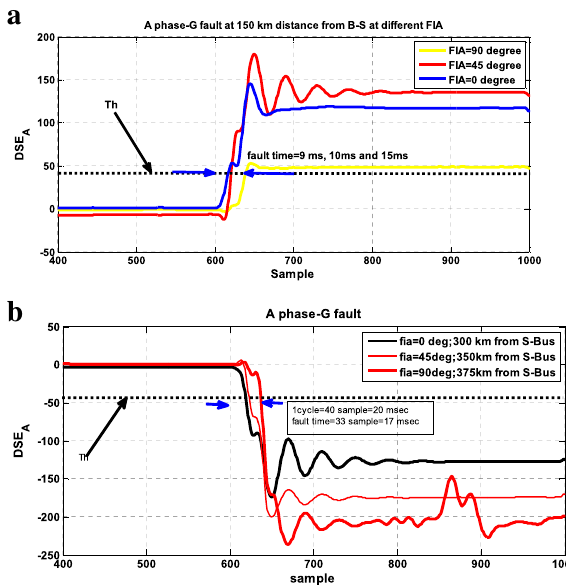
Fig. 5 a . A phase-G fault at 150 km from B-S at FIA = 0 0 , 45 0 and 90 0 . b . A phase-G fault, 300 km,350 km & 375 km from S- Bus (B-S), FIA = 0 0 ,45 0 ,90